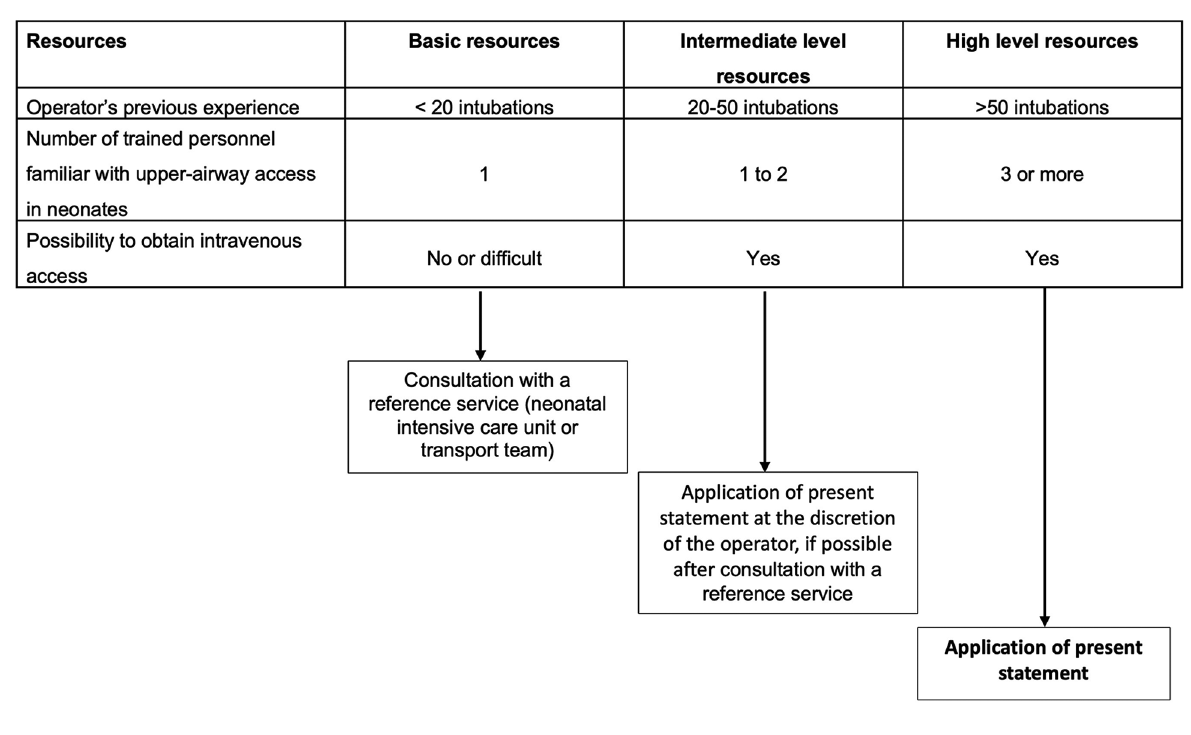
FIGURE 1 Conditions of statement application based on available